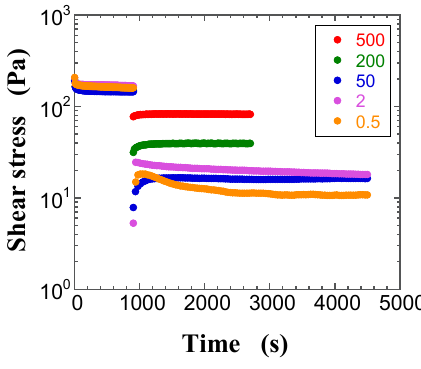
Figure 2. Plots of the transient shear stress for the FS suspension at the volume fraction of silica φ = 0.013 at the shear rates of 0.5 s − 1 (filled orange circle), 2 s − 1 (filled purple circle), 50 s − 1 (filled blue circle), 200 s − 1 (filled green circle), and 500 s − 1 (filled red circle) as a function of time.